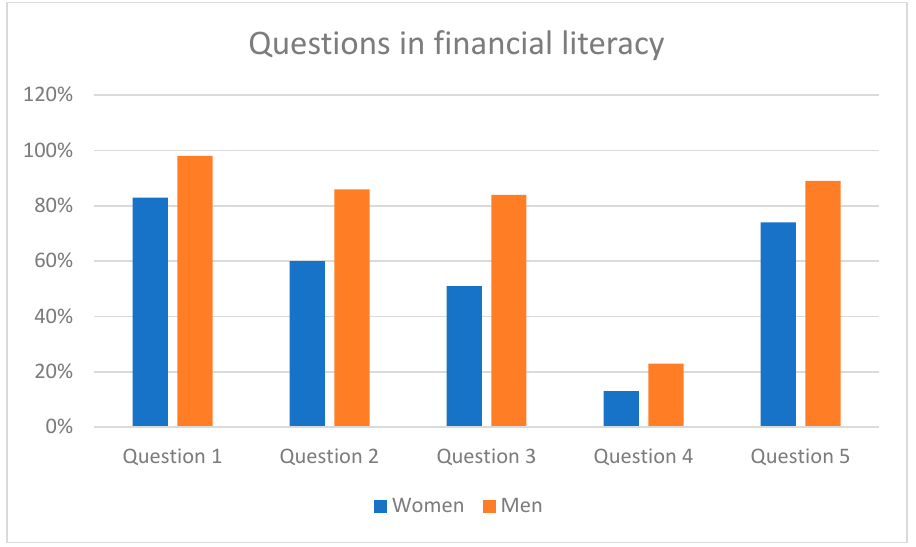
Figure 3. Questions in financial literacy.